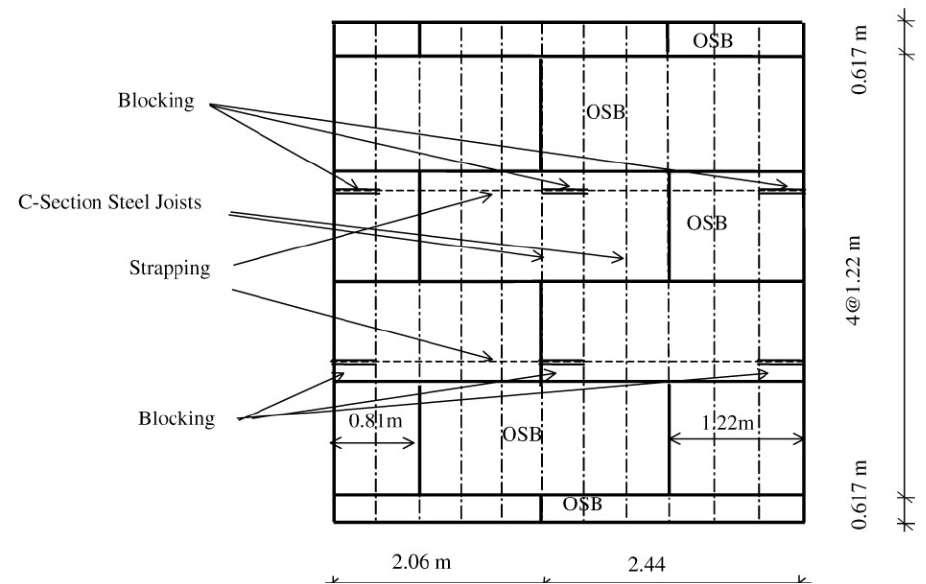
Figure 1. Plan-view of the cold-formed steel-timber composite floors tested by Xu and Tangorra [34]. Tongue-in-groove OSB sheathing was used as the subflooring. Reproduced with permission.